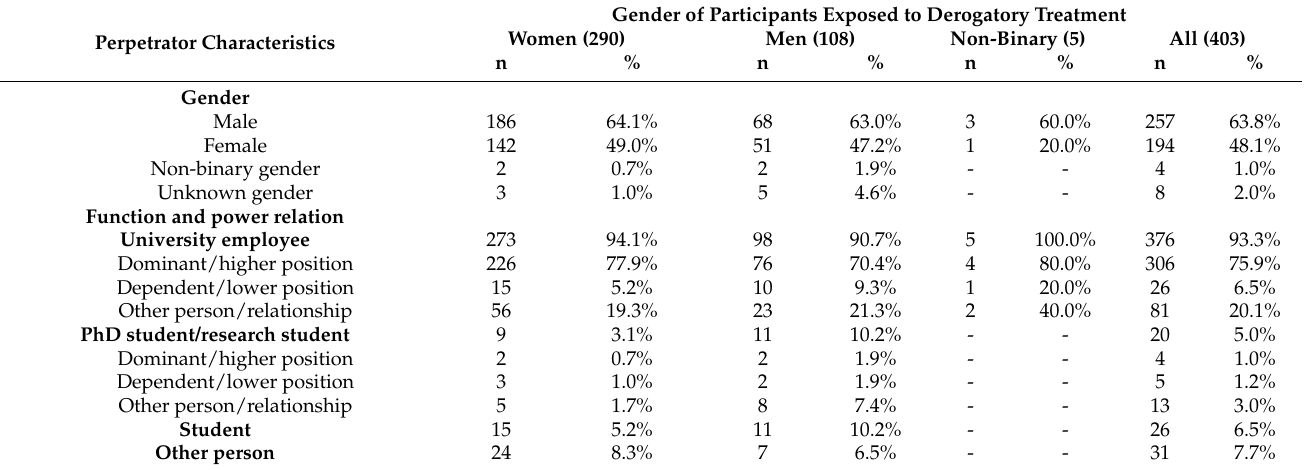
Table 4. Gender, function and power relation of the perpetrator/perpetrators * of derogatory treat- ment by gender of exposed